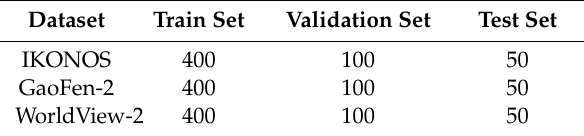
Table 4. The distribution of images for training, validation, and